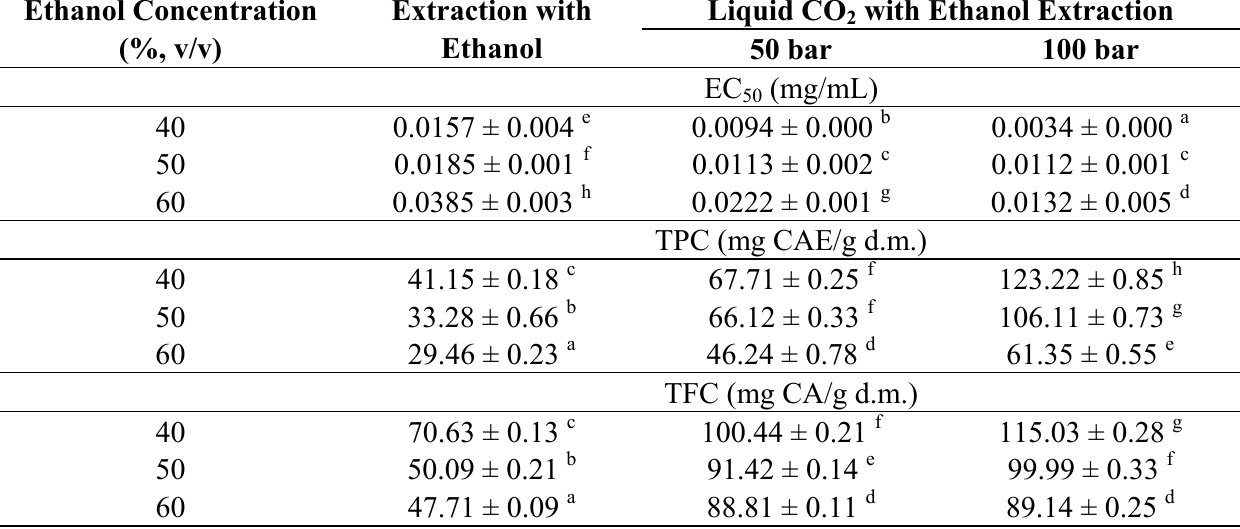
Table 3. Free radical scavenging activity (EC flavonoid content (TFC) of mate ( Ilex paraguariensis ) leaves